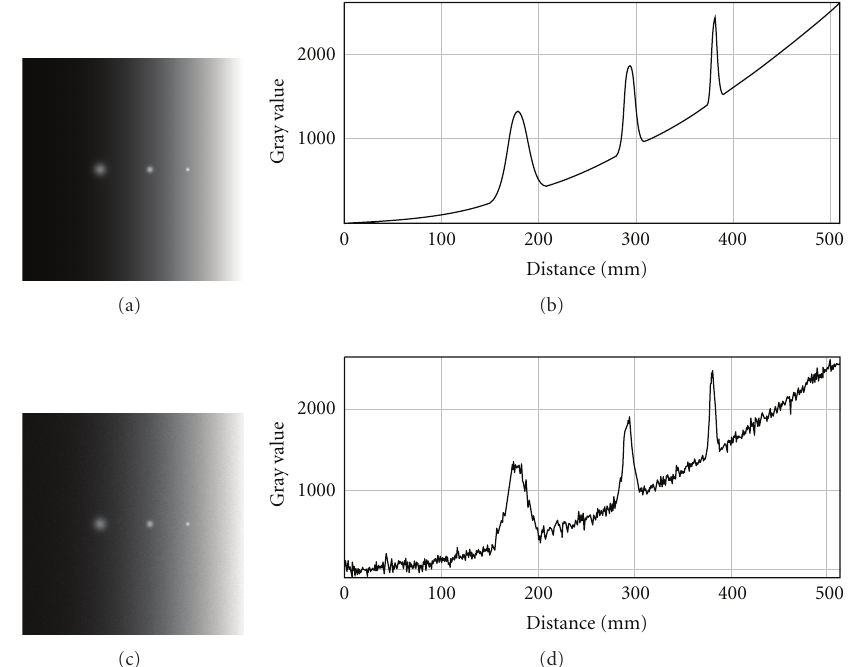
Figure 10: Program-simulated images with polynomial noisy background and tubular objects with Gaussian intensity profiles.